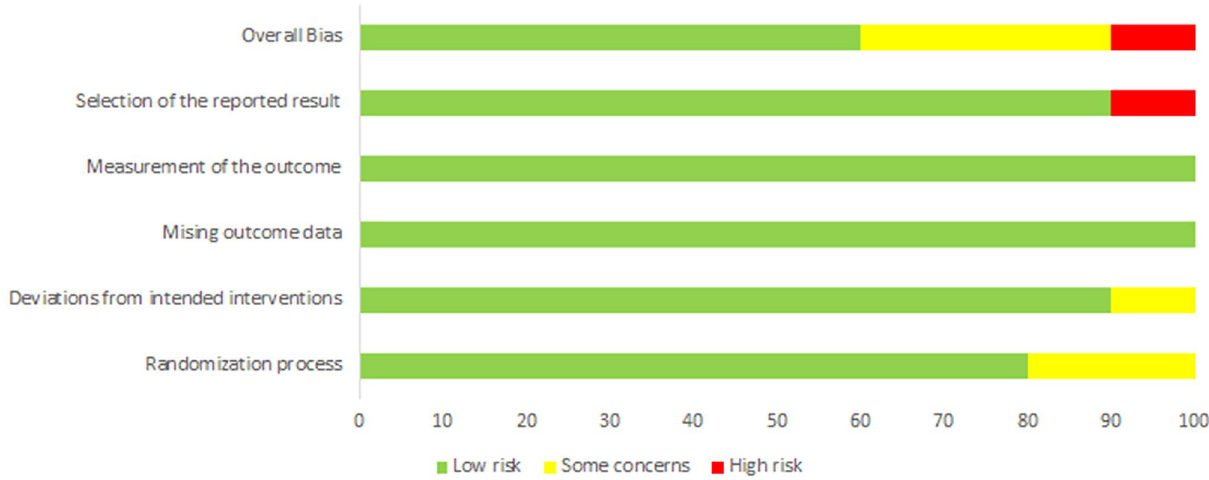
Figure 2. Risk of bias graph: based on researchers’ opinions about each risk of bias item, percentages are presented for all included studies.